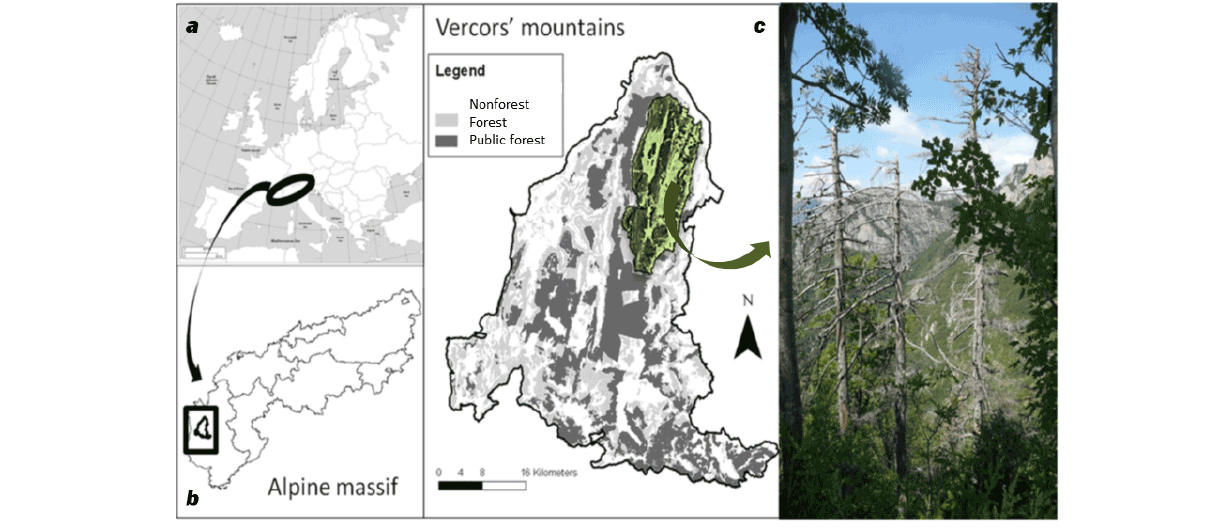
Fig. 1 . Study area location in the Alpine Mountain Range and the site of Quatre-Montagnes (green area) at the north of Vercors Regional Park (VRNP), French Alps (Partelow 2016). Panel (a) represents the location of the Alpine massif in the European continent. Panel (b) represents the Vercors Regional Park (VRNP) location in the Alpine massif. Panel (c) represents the location of the study area site Quatre-Montagnes (green area) as well as nonforested (white) and forested (light gray) areas inside the Vercors. Moreover, panel (c) also shows public forest areas within the Vercors’ mountains (dark